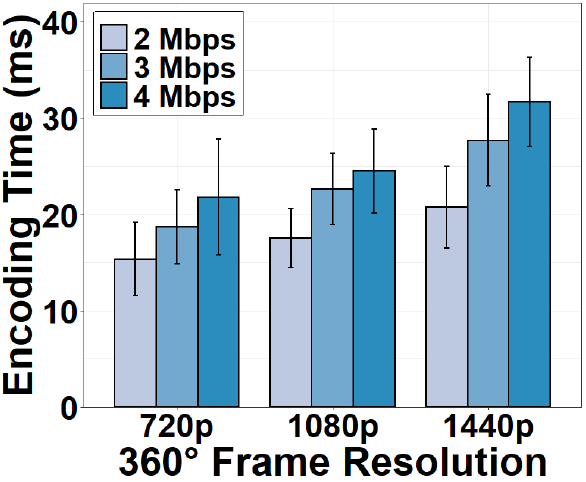
Figure 8. Encoding time under different encoding bitrates.